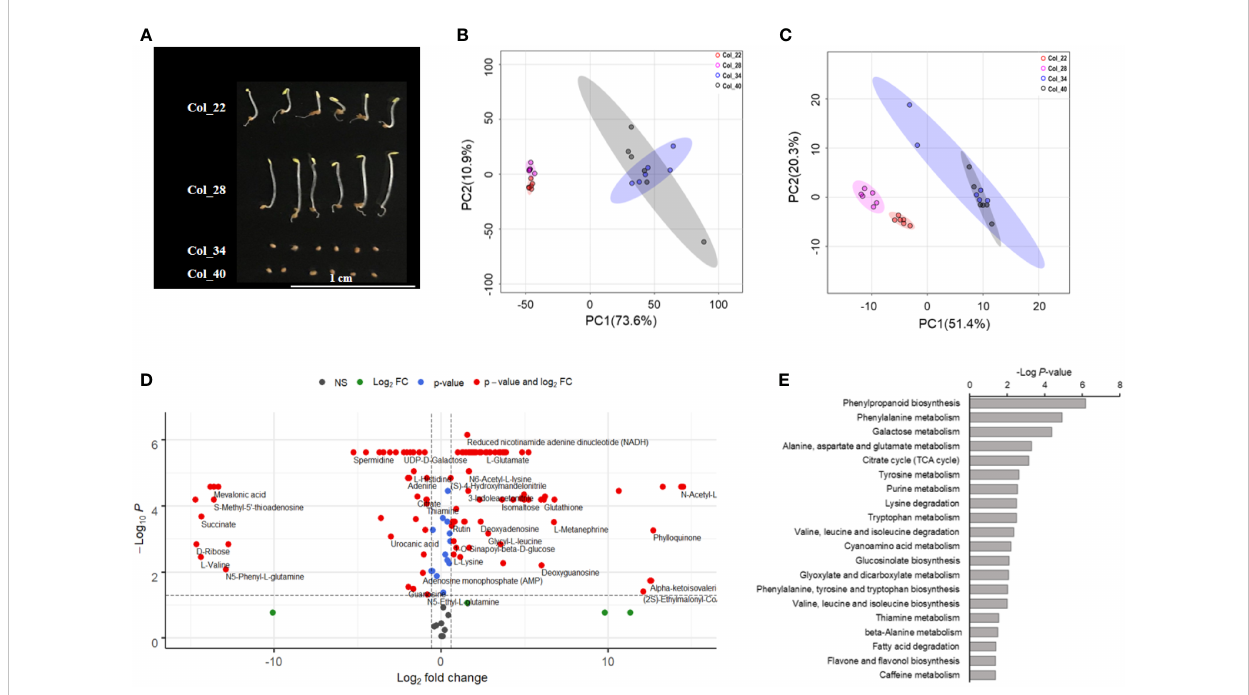
FIGURE 1 Global analysis of metabolite and lipids for Arabidopsis seeds germination/seedling growth under four temperatures conditions. (A) The observation of seeds germinated at 22°C, 28°C, 34°C and 40°C, respectively. Col_22 means seeds germinated at 22°C, Col_28 means seeds germinated at 28°C, Col_34 means seeds germinated at 34°C, Col_40 means seeds germinated at 40°C. (B) Principal component analysis of the inter-group metabolic differences during Arabidopsis seeds germination/seedling growth under four temperatures conditions. (C) Principal component analysis of the inter- group lipids differences during Arabidopsis seeds germination/seedling growth under four temperatures conditions. (D) Signi fi cantly distinct metabolites between moderate (22°C, 28°C), and extreme high temperatures (34°C, 40°C) were analyzed by volcano plot. X-axis was Log2 fold change and the y-axis was – Log10 P value. The red dots on the left indicated that metabolites of seeds germination at moderate temperature signi fi cantly reduced level, compared with the extreme high temperature. The red dots on the right indicated metabolites level increased signi fi cantly. Blue dots represented metabolites with only P <0.05 and green dots represent metabolites with only FC>1.5. Gray dots referred to all other identi fi ed metabolites with no signi fi cant changes between moderate and extreme high temperatures. (E) Analysis of metabolic pathways based on the differences of metabolites between moderate (22°C, 28°C) and extreme high temperatures (34°C, 40°C). Bioinformatic analysis was performed using the MetDNA tools at